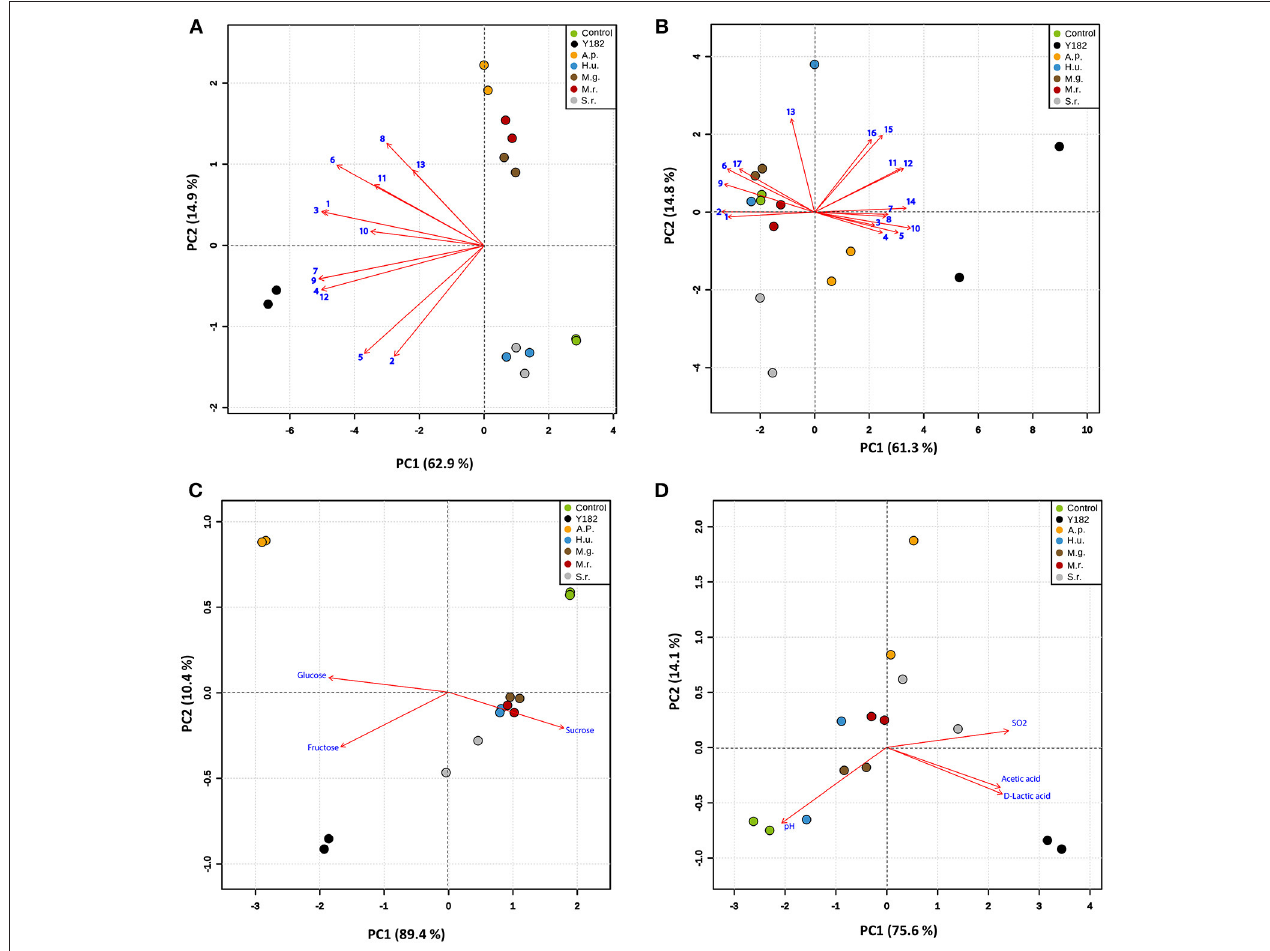
FIGURE 1 | Principal component analysis (PCA) of the volatile and chemical profiles of the different nectars, including: Control, non-inoculated, yeast-free nectar; Y182, nectar fermented with the reference strain Saccharomyces cerevisiae Y182; A.p., Aureobasidium pullulans -fermented nectar; H.u., Hanseniaspora uvarum -fermented nectar; M.g., Metschnikowia gruessii -fermented nectar; M.r., Metschnikowia reukaufii -fermented nectar; S.r., Sporobolomyces roseus -fermented nectar. All analyses were performed on cell-free nectar solutions (two biological replicates, each with two technical replicates; mean values for each biological replicate are used in the analysis). Score plots visualize the location of each analyzed sample on each PC with the percentage of explained variation in parentheses, whereas vectors (in red) visualize the loadings for each variable. (A) PCA showing variation in microbial volatile composition across the different treatments. Vector numbers refer to the different volatile compounds: (1) Acetaldehyde, (2) Ethyl acetate, (3) 2-Methyl propanol, (4) Ethyl propionate, (5) Propyl acetate, (6) 3-Methyl-1-butanol, (7) Isobutyl acetate, (8) Ethyl butyrate, (9) Isoamyl acetate, (10) Amyl acetate, (11) 2-Phenyl ethanol, (12) Dimethyl disulfide, and (13) Methanethiol. (B) PCA showing variation in the amino acids composition across different treatments. Vector numbers refer to the different amino acids: (1) Aspartic acid, (2) Glutamic acid, (3) Asparagine, (4) Serine, (5) Glutamine, (6) Histidine, (7) Glycine, (8) Threonine, (9) Arginine, (10) Alanine, (11) Tyrosine, (12) Valine, (13) Methionine, (14) Phenylalanine, (15) Iso-Leucine, (16) Leucine and (17) Lysine. (C) PCA showing variation in the sugar composition across the different nectars investigated. (D) PCA showing variation in acidity (pH), and the acids and sulfur dioxide composition in the different nectars. The percentage of variation of the data explained by PC1 and PC2 is shown